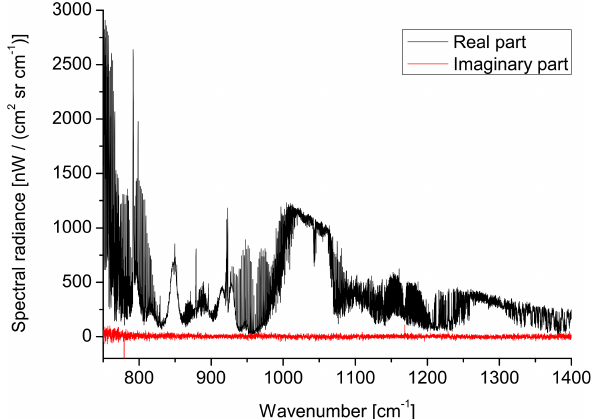
Figure 15. Spectrum from a chemistry mode measurement on 28 September 2012, 10:45UT at 29.67 ◦ N, 43.41 ◦ E for a tangent altitude of about 13.3km after co-adding of one horizontal line (45 pixels used). The flight altitude was about 15.1km.